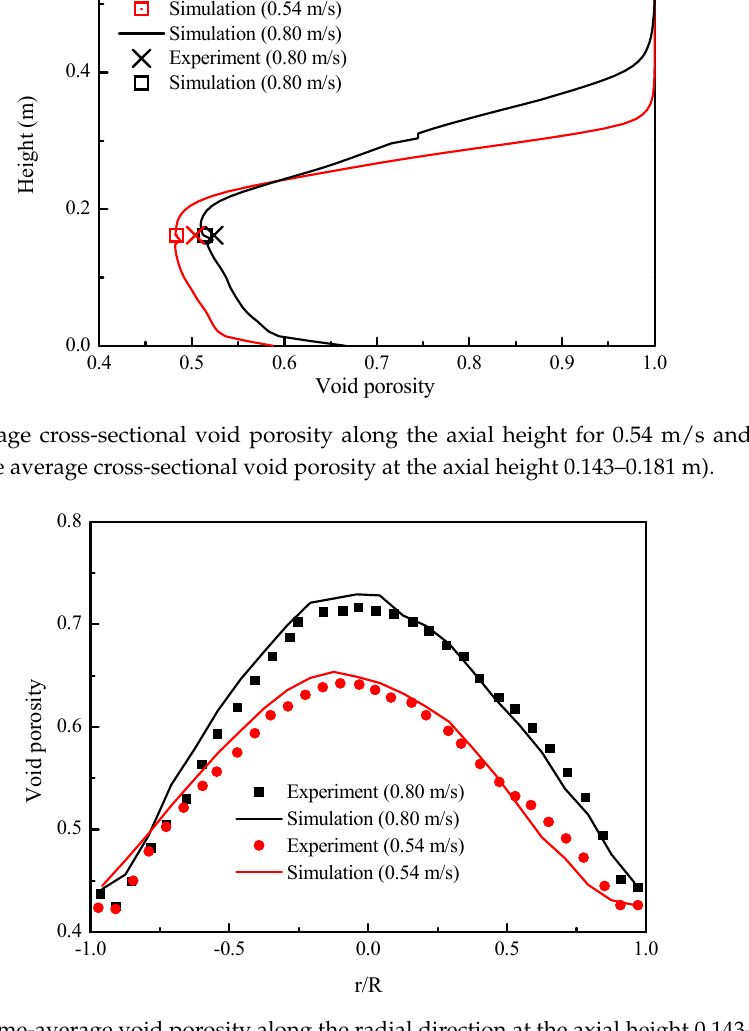
Figure 9. The time-average void porosity along the radial direction at the axial height 0.143–0.181 m.